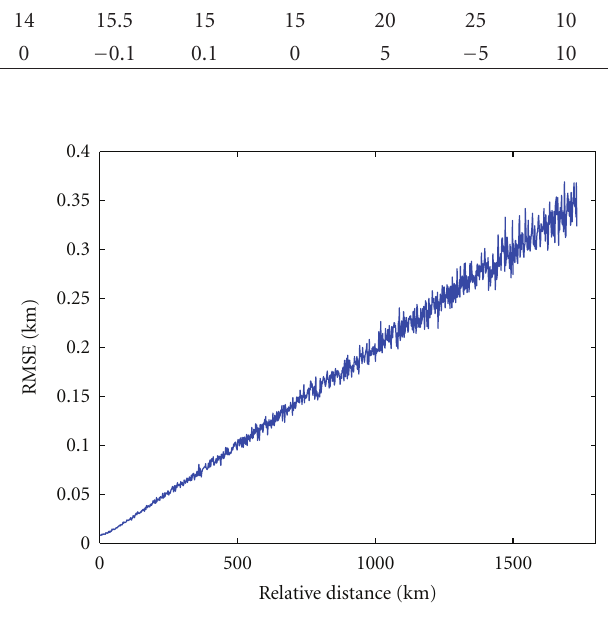
Figure 5: Measurement error wrt.